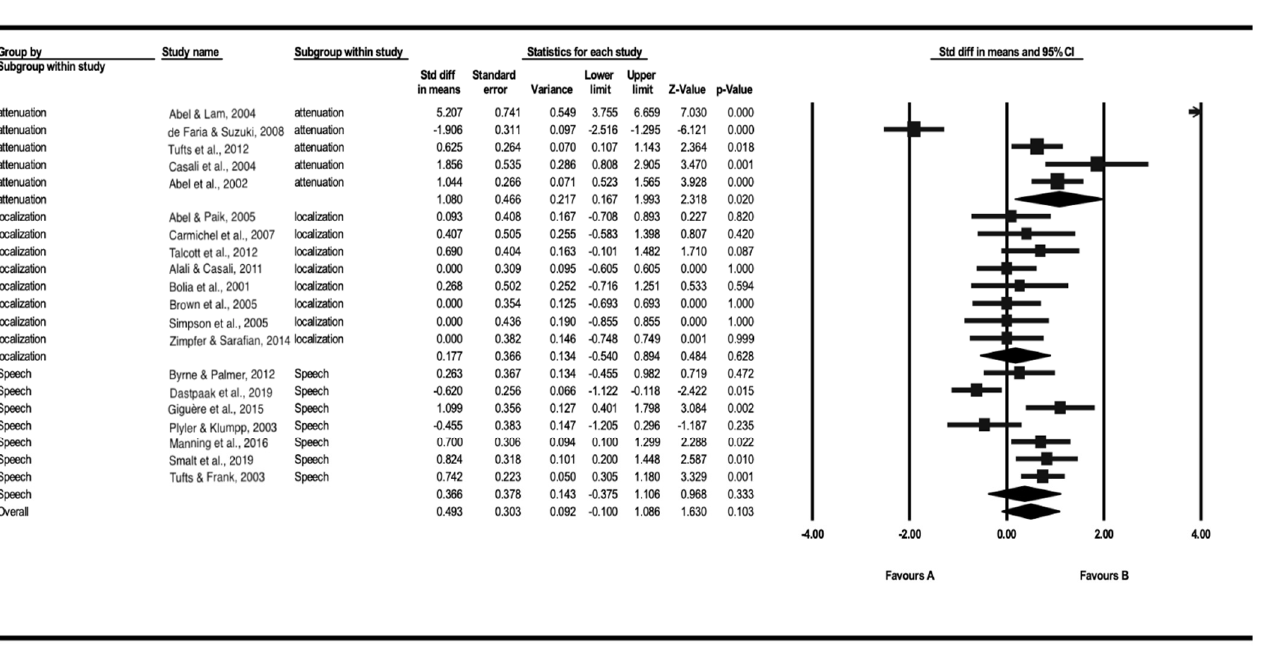
Figure 3. The forest plot of the subgroup analysis for sound attenuation ( n = 6), sound localization ( n = 9), and speech perception ( n = 8).